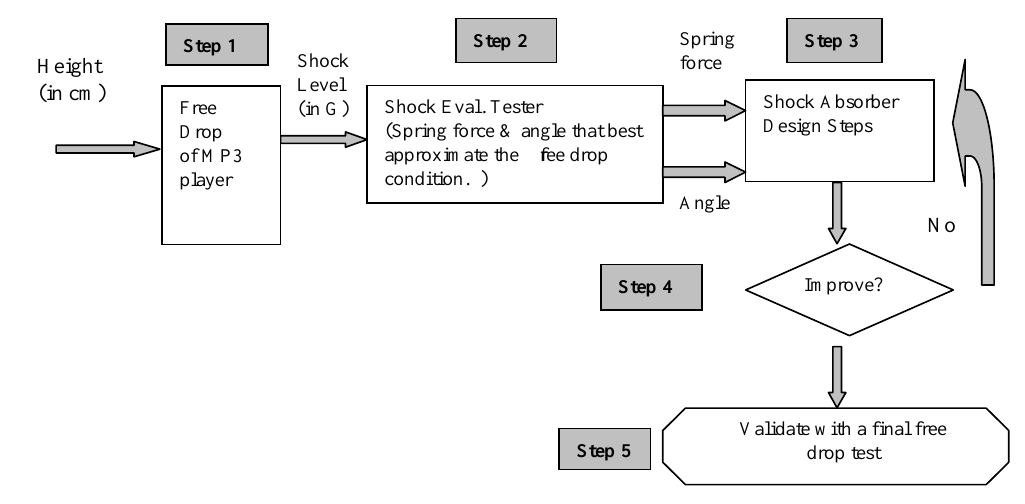
Fig. 8. Shock testing flow chart using tilt